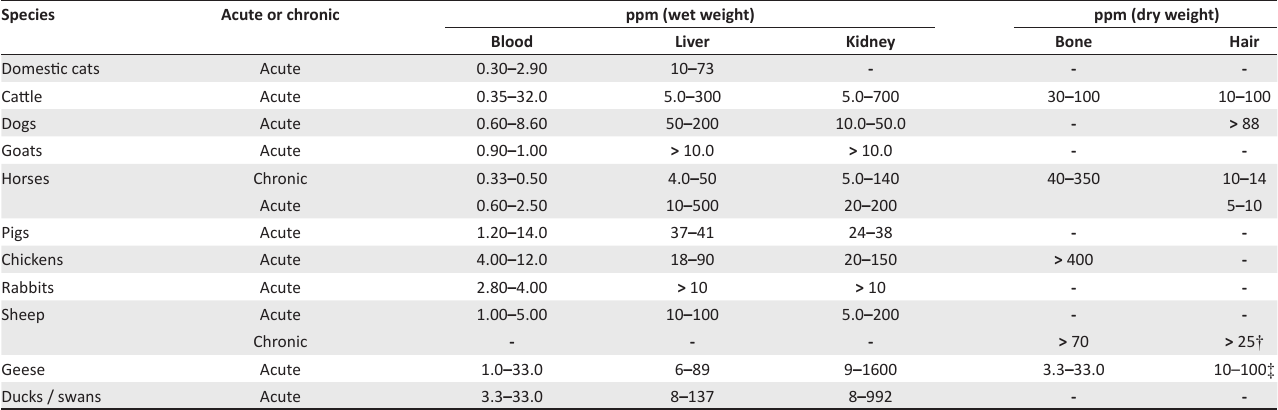
TABLE 1: Published reference ranges for lead toxicity in selected species. Species Acute or chronic ppm (wet